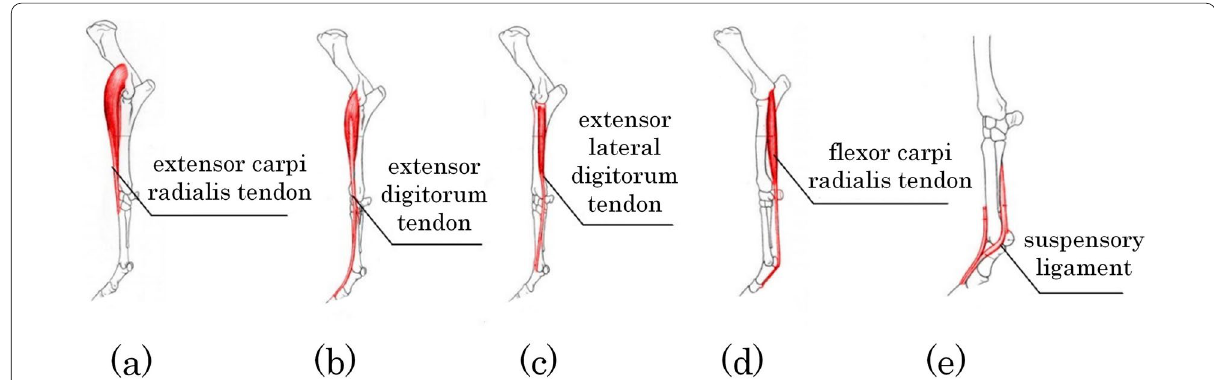
Figure 4 Distribution of the main tendons and ligaments in the ruminant forelimb: a extensor carpi radialis tendon, b extensor digitorum tendon,